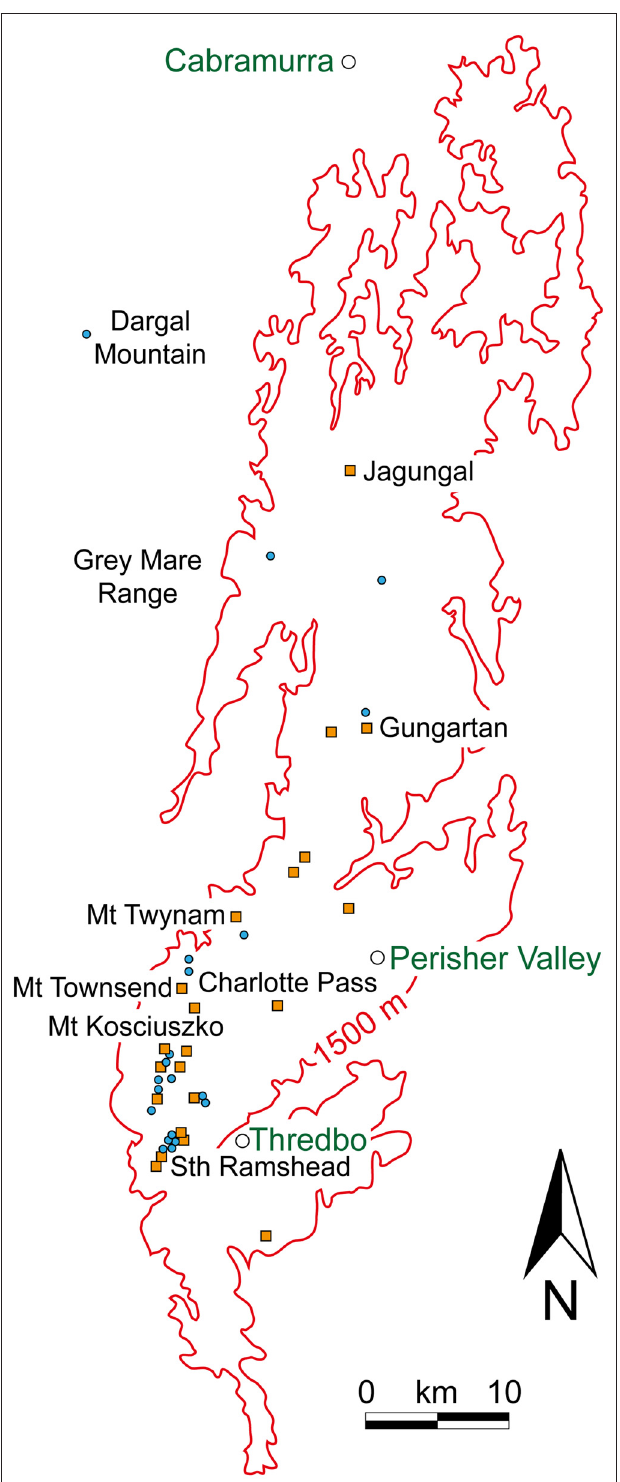
FIGURE 9 | The known estivation sites (orange squares) and temporary camps (blue circles) for Bogong moths above 1500 m (red isoline) in the Snowy Mountains of NSW. The geographical region represented in this figure is the region bounded by the white box in Figure 6 . Town names are shown in green text . Redrawn from Green